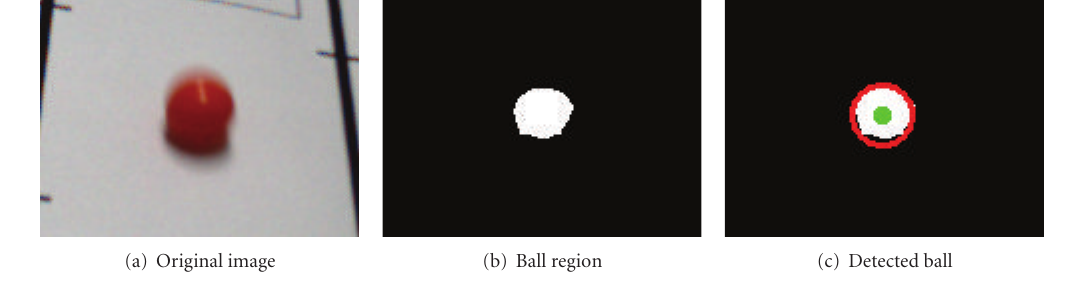
Figure 15: Ball detection.